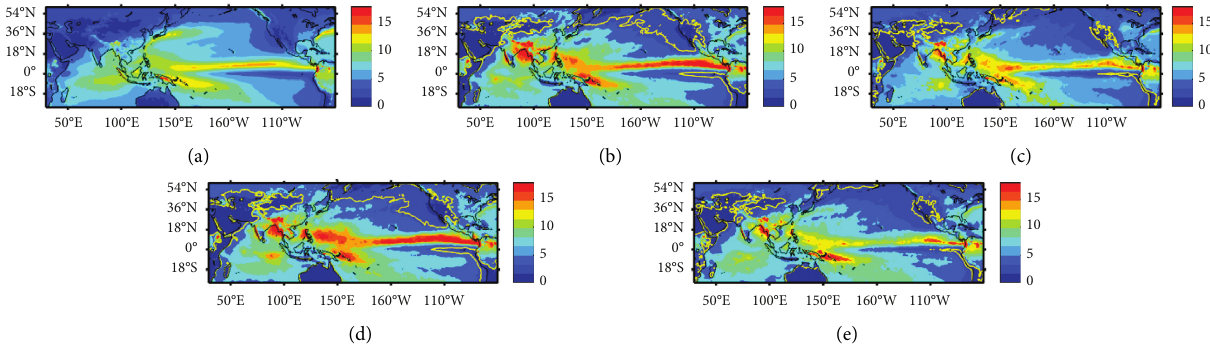
Figure 4: Composite moisture budget (units: mm) for boreal summer (JJA) in (a) climate mean and four cases: (b) developing-cool PDO, (c) developing-warm PDO, (d) decaying-cool PDO, and (e) decaying-warm PDO. Yellow lines indicate the 95% and higher confidence levels using t